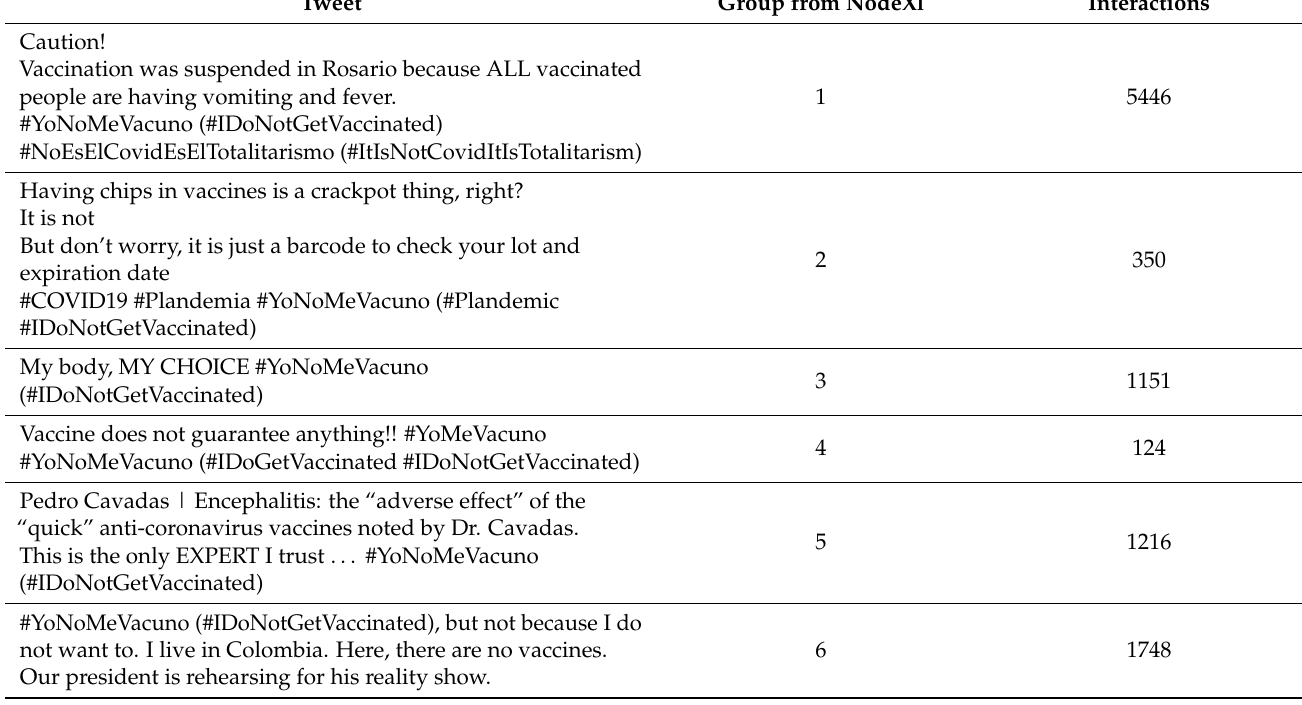
Table 1. Most interacted tweets among groups described in Figure 1. Tweet Group from NodeXl